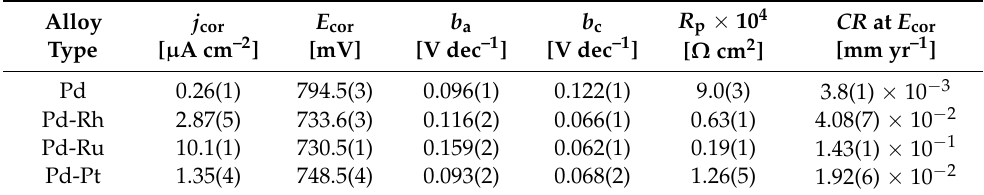
Table 2. The corrosion resistance parameters for electrodeposited Pd and Pd-binary alloys in deaer- ated 0.5 M H 2 SO 4 (see Figure 2).